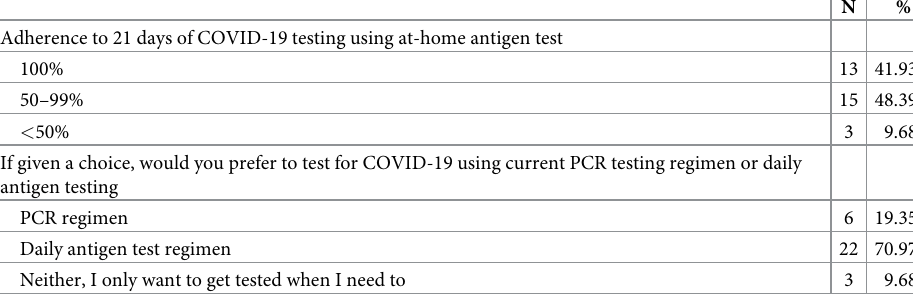
Table 2. COVID-19 testing adherence and